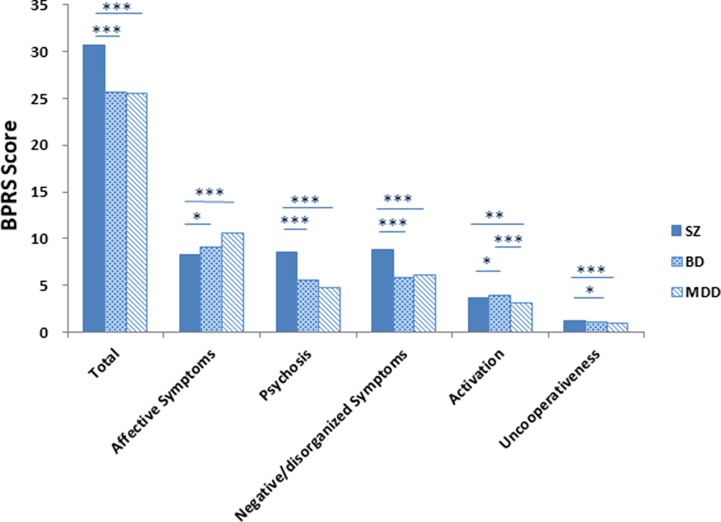
The Brief Psychiatric Rating Scale (BPRS) total scores and factor scores by diagnosis. Note: *P < 0.05, **P < 0.01, ***P < 0.001. Patient groups differed on BPRS scores. Bipolar disorder (BD) and major depressive disorder (MDD) groups differed from the schizophrenia (SZ) in “total score,” “affective symptoms,” “psychosis,” “negative/disorganized symptoms,” and “uncooperativeness” dimensions scores but did not differ from each other. For “activation,” SZ, BD, and MDD differed from each other.